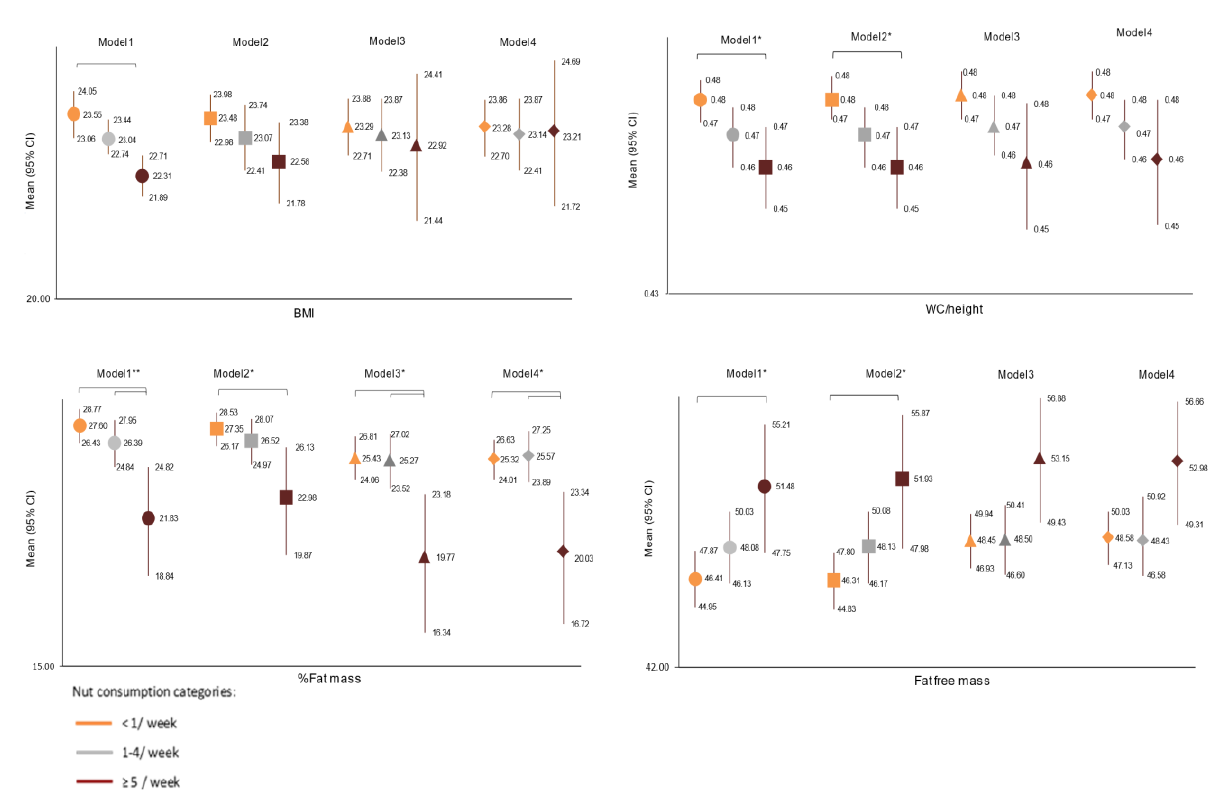
Figure 2. Mean difference and 95% confidence intervals in body composition variables (BMI, WC/height, %fat mass and fat free mass) by categories of nut consumption. О : Model 1: Adjusted by age and sex; □ : Model 2: Model 1+ total energy intake; ∆ : Model 3: Model 2 + CRF (vo2 max); ♦ : Model 4: Model 3 + muscle strength index. * p < 0.05, ** p < 0.001.